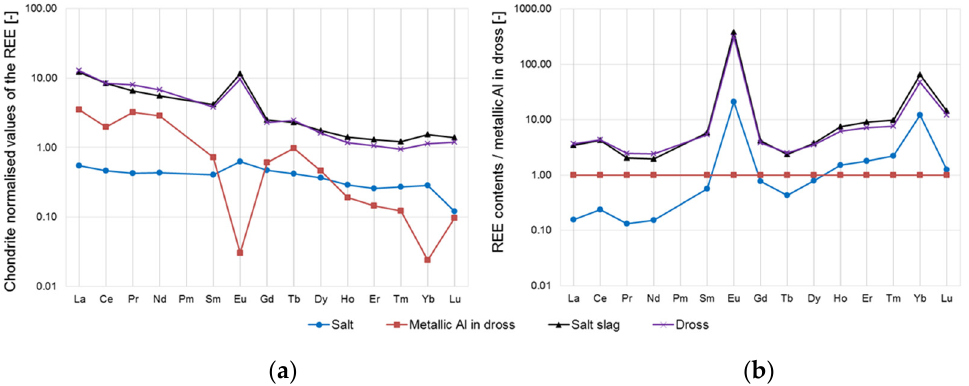
Figure 5. Mass fractions of the lanthanides in the different phases during the remelting of the dross in the TBRC: ( a ) chondrite-normalised and ( b ) normalised to the mass fractions of the metallic aluminium produced.